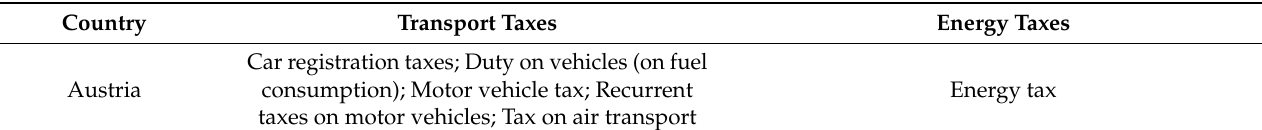
Table 1. Energy and transport taxes existing in the European